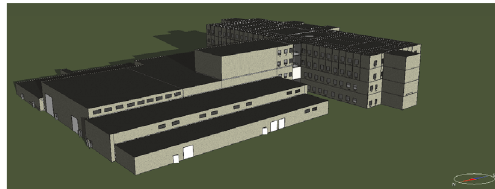
Figure 1: 3D model for the